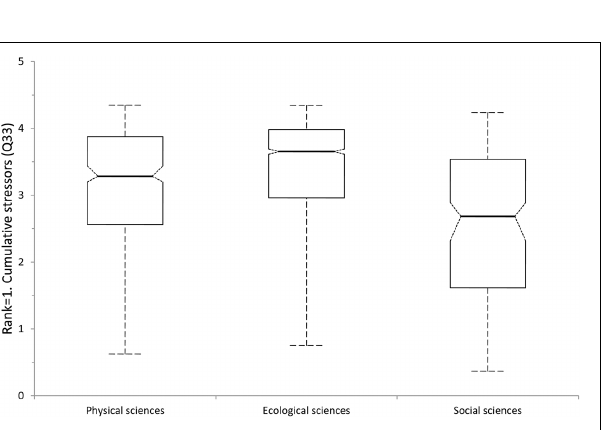
FIGURE 3 | Box plot of median ranking score for top-ranked question (cumulative stressors) for each of seven